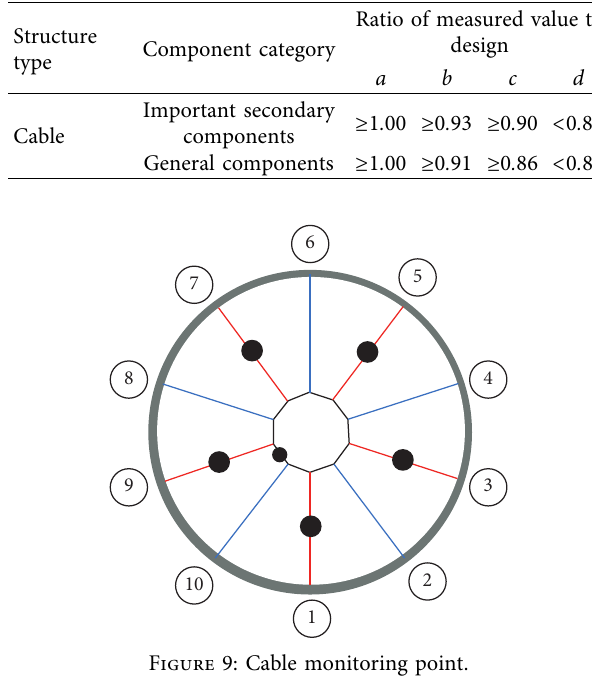
Table 2: Upper radial cable force ( N ). Table 5: Forced evaluation standards.